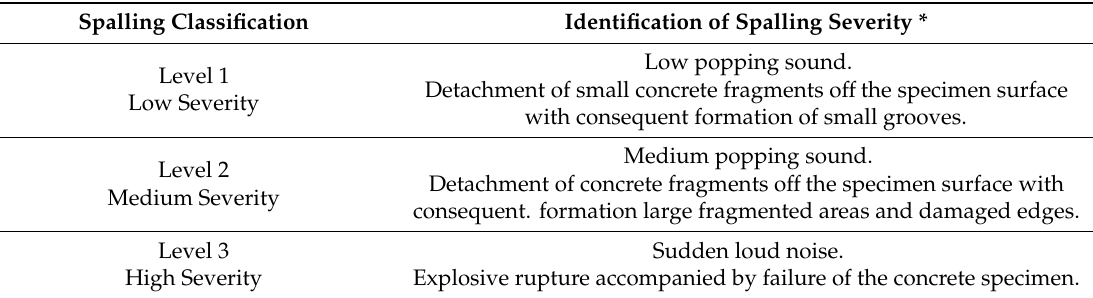
Table 2. Spalling classification.